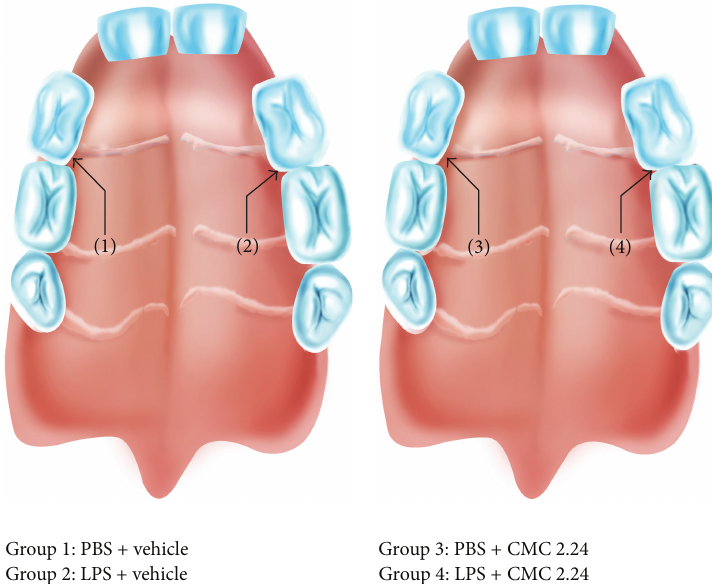
Figure 1: Diagrammatic representation of the four experimental groups using “split-mouth”